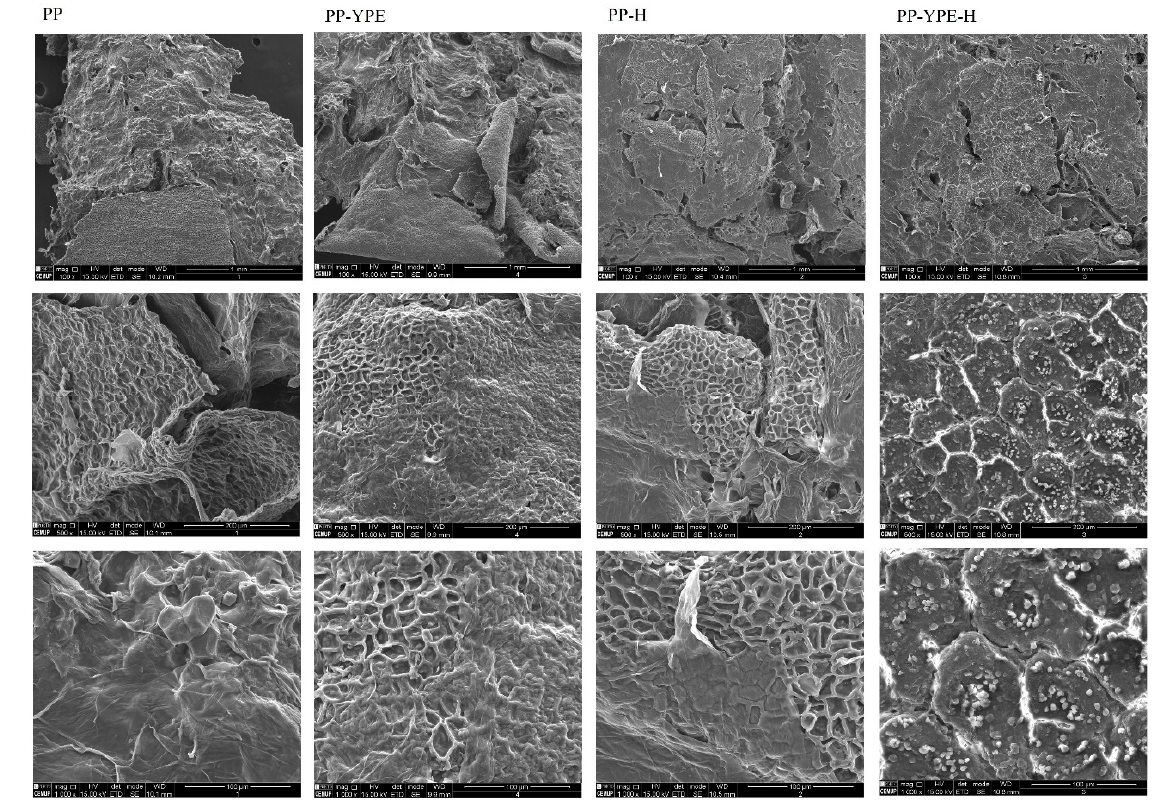
Figure 6. Scanning electron micrographs of PP samples enriched with YPE (PP-YPE) and subjected to thermal treatment (PP-H and PP-YPE-H). Samples are presented in three magnifications (from top to bottom: ×100; ×500 and ×1000).